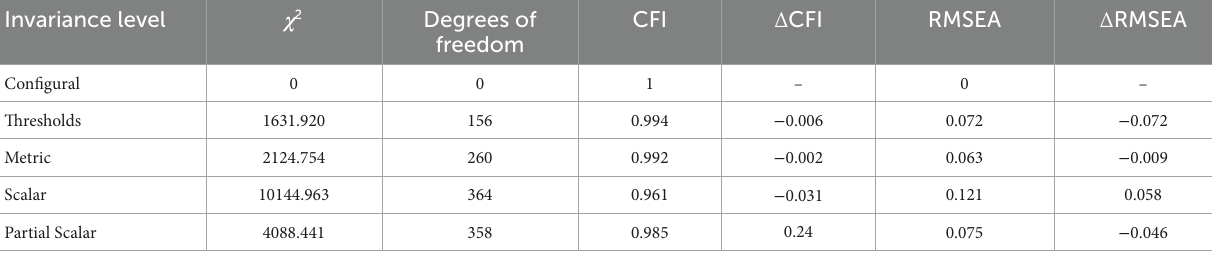
TABLE 3 Global fit indices for different levels of measurement invariance of positive affect.